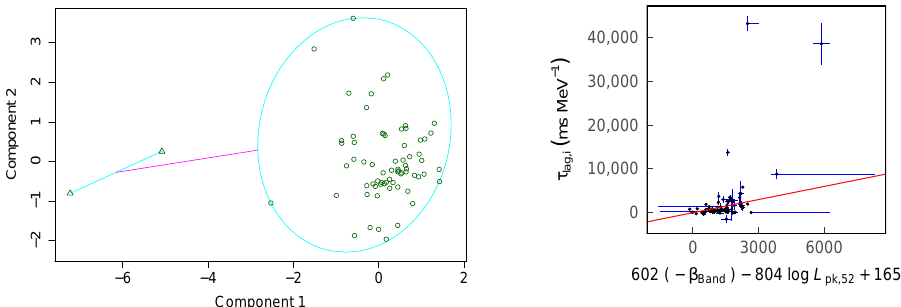
Figure 6. Similar to Figure 1, with the three parameters being τ lag,i , β Band and L pk,52 . The outliers are GRB 980425B and 030528A. The linear regression result is τ lag,i = ( 602 + 640 − ) . The adjusted R 2 is 0.21. log L pk,52 + ( 165 + 520 − 1400